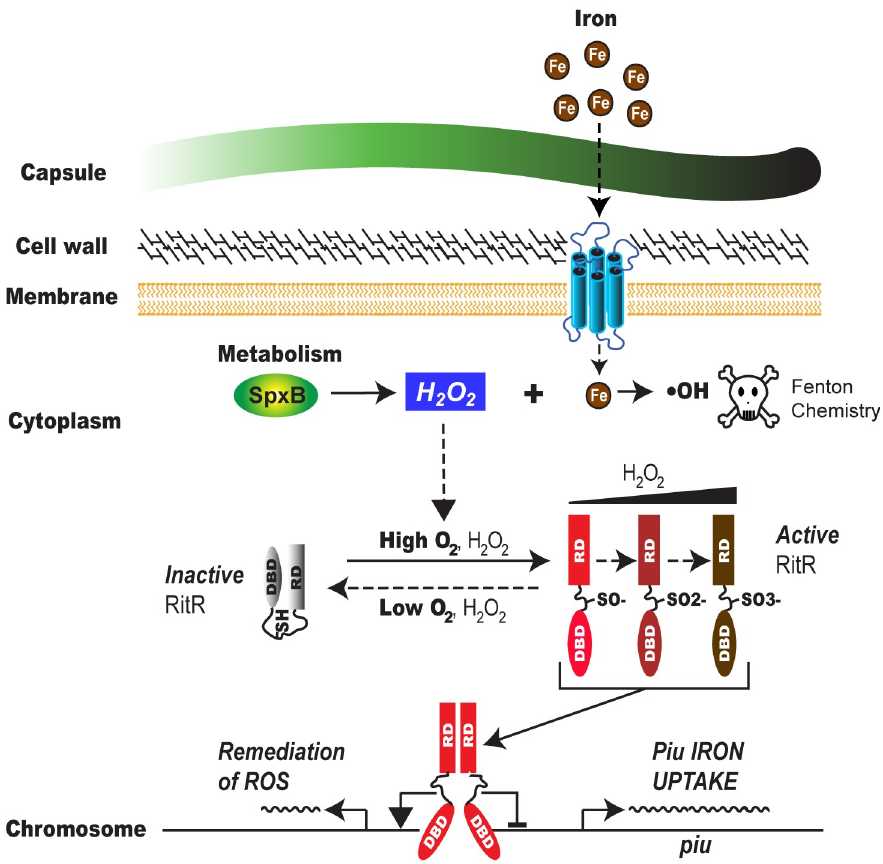
Fig 7. Schematic representation of RitR regulation in S . pneumoniae . Hydrogen peroxide (H 2 O 2 ) is primarily produced from S . pneumoniae metabolism via pyruvate oxidase (SpxB). When present, iron must be kept out of the cell, or alternatively, stored such that it cannot react to yield Fenton chemistry, thereby causing cellular damage. RitR regulates this process by oxidation though Cys128 in high H 2 O 2 produced in aerobic environments such as the nasopharynx, which allows its open conformation and release of the DNA-binding domain (DBD) for the Regulatory Domain (RD) to interact with the Piu promoter, repressing iron uptake. Simultaneously, RitR is postulated to remediate iron toxicity through activation of DNA repair and iron sequestration [25]. Conversely, when H 2 O 2 concentrations are low, RitR stays in its inactive form, where the interaction of the RD with the DBD prevents its binding to the Piu regulatory region, ultimately allowing for more iron to enter the cell. The potential oxidation states of RitR (SO - , SO 2- , SO 3- ) and their regulatory consequences remain enigmatic. upper respiratory tract. Most strikingly, we see the C128D phosphomimetic completely allevi- ating this effect, lending further support to the notion that keeping intracellular iron concen- trations low when the pneumococcus is producing high levels of peroxide in the airways is of benefit to its survival. Interestingly, a study by Weiser and colleagues identified human sidero- calin, a siderophore binding protein, as the most highly upregulated transcript during pneu- mococcal nasopharyngeal colonization. This host strategy was postulated to be a reason why species such as S . pneumoniae that require little iron and do not produce nor rely on sidero- phores might be so successful at colonizing respiratory tract mucosal surfaces, which contain extremely low levels of accessible iron [63]. Nevertheless, in this environment S . pneumoniae still likely requires some iron to colonize, and must therefore maintain strict intracellular levels of this element to avoid Fenton chemistry with its high SpxB activity. In further support of this hypothesis, RitR does not seem to be required for infection in low free oxygen environments like the blood [25, 27].